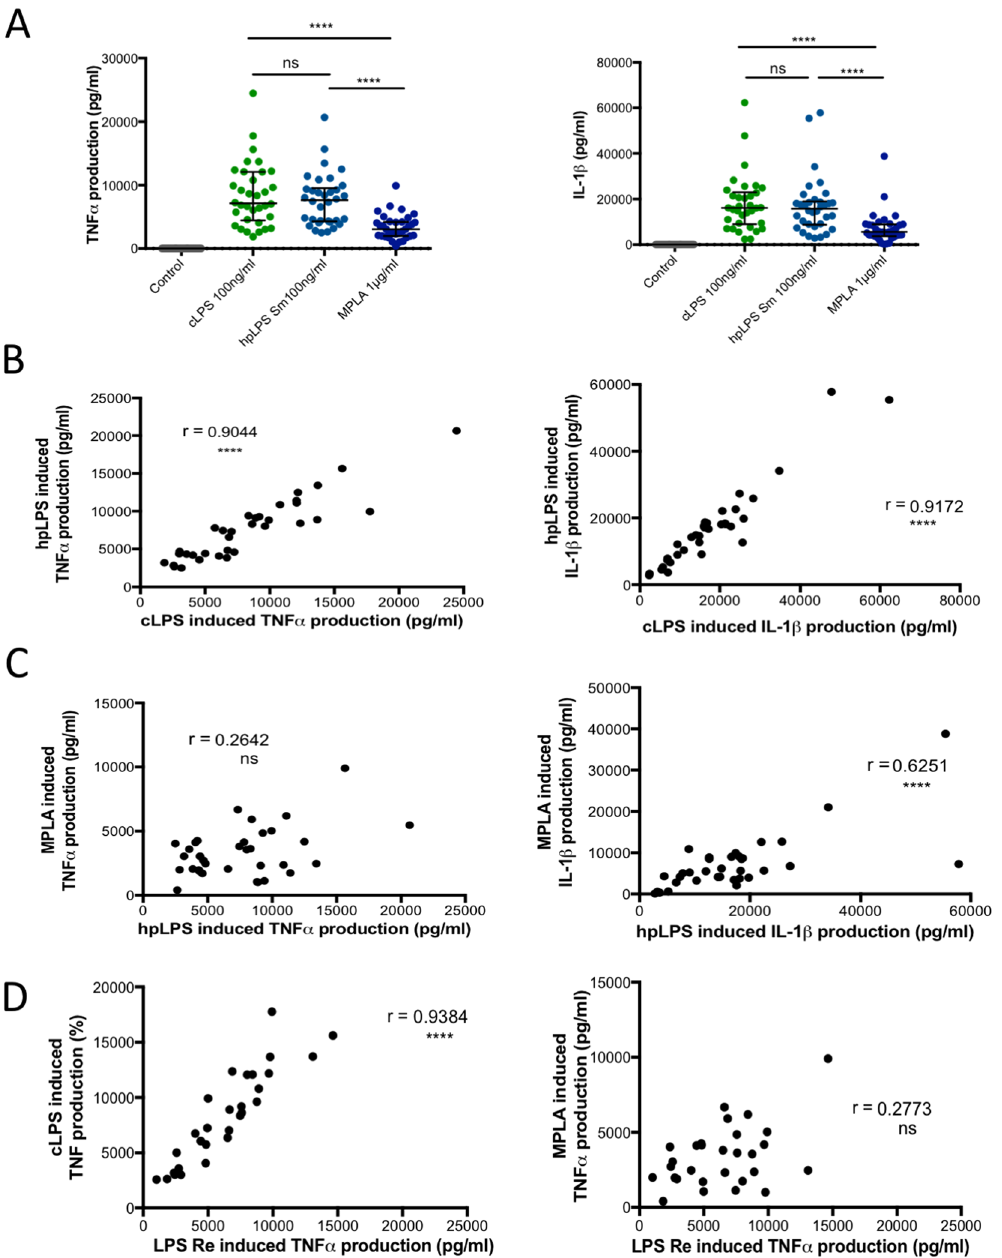
Figure 1. TNF and IL-1 β production by human blood adherent mononuclear cells stimulated with 100 ng/ ml conventional Escherichia coli smooth LPS O111:B4 (cLPS), highly purified smooth Salmonella abortus equi LPS (hpLPS), highly purified rough S. minnesota Re595 LPS (LPS Re) or 1 µ g/ml MPLA. ( A ) Individual responsiveness of n = 34 individuals. ( B ) Correlations between individual responsiveness to cLPS and hpLPS in terms of TNF and IL-1 β production. ( C ) Correlations between individual responsiveness to MPLA and hpLPS in terms of TNF and IL-1 β production. ( D ) Correlations between individual responsiveness to rough Re LPS and cLPS or MPLA and in terms of TNF. Each dot represents one individual donor. **** p <